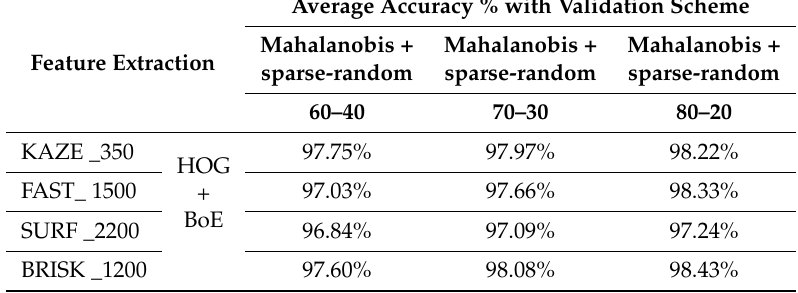
Table 3. Impact of validation splits on average accuracy for KAZE, FAST, BRISK and SURF (using Mahalanobis and sparse-random combination).